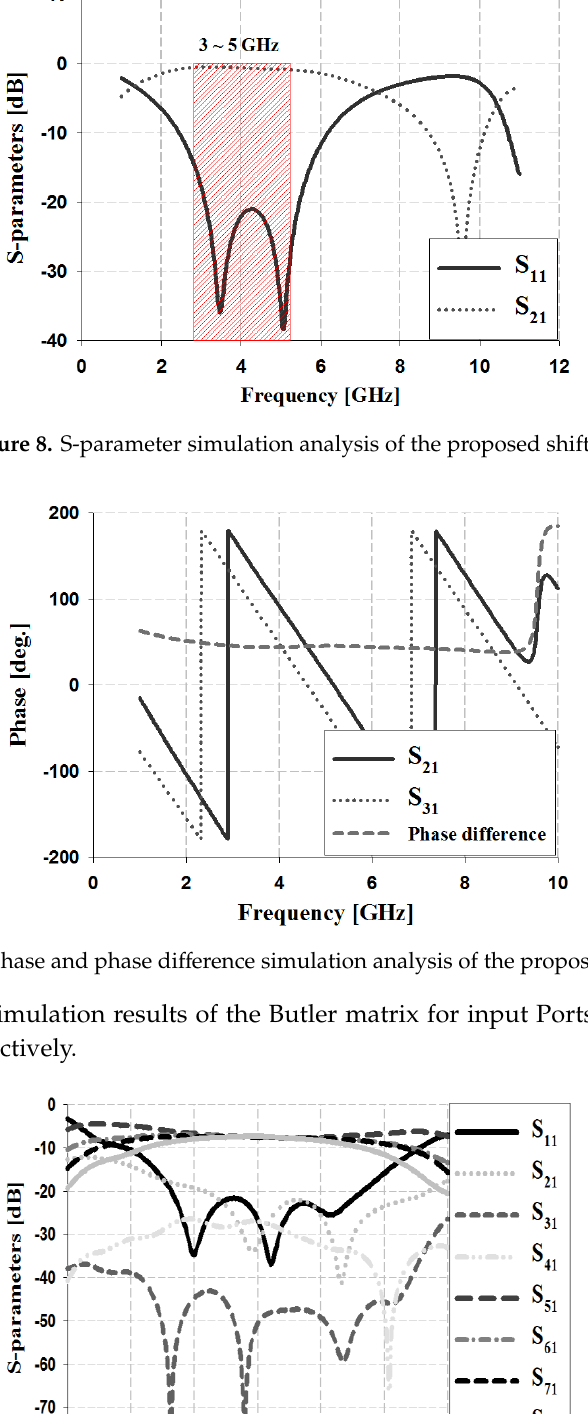
Figure 10. Simulation analysis of S-parameters for input Port 1.